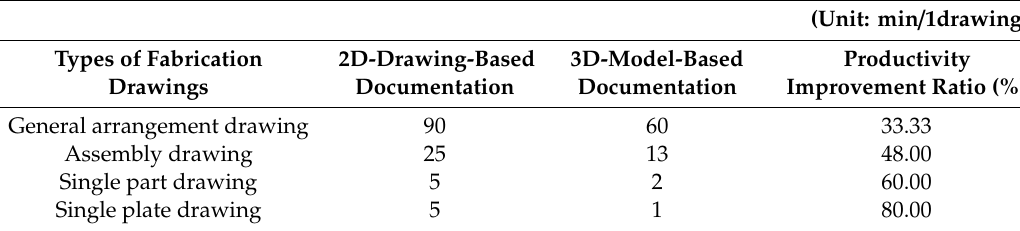
Table 2. Productivity comparison of two documentation methods